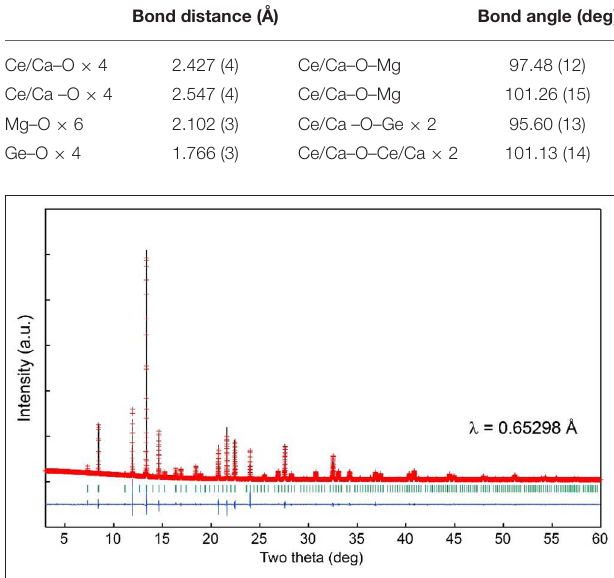
FIGURE 3 | Observed (crosses), calculated (upper solid line), and difference (lower solid line) plots obtained from the Rietveld analysis of the room temperature synchrotron X-ray powder diffraction data collected using ground single crystals of Ce 2 CaMg 2 Ge 3 O 12 . Vertical lines represent expected Bragg peak